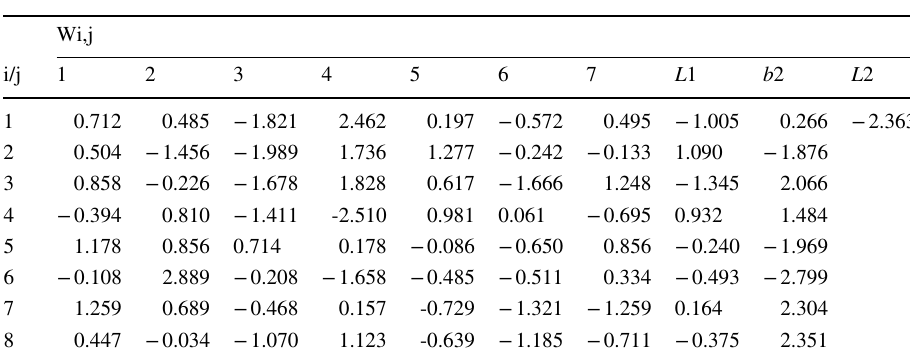
Table 2 The tuned weights and biases of the ANN-based EUR equation